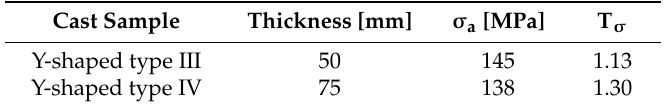
Table 4. Solidification times in the positions shown in Figure 5 obtained from the numerical analysis. The value read at the node in the center of each sample was considered. Table 3. Fatigue strength at 50% survival probability and scatter index at 10 7 cycles considering cast samples thickness.